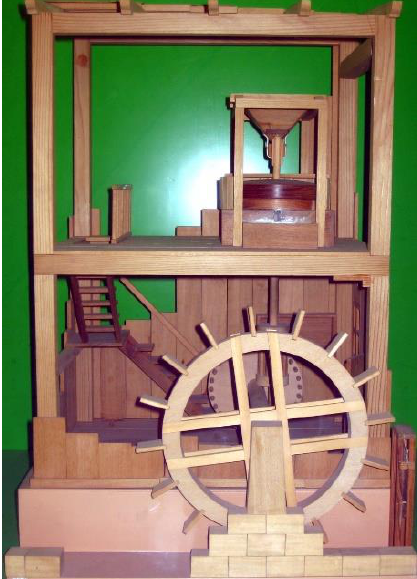
Figure 12. Reconstruction of a grain-mill following the principles of Vitruvius (ca 80 – 15 BC). The undershot waterwheel powered the gear mechanism (lower floor) and thus induced the millstone (upper floor) to function (https://en.wikipedia.org/wiki/Public_domain, assessed on 1 September 2022 ).